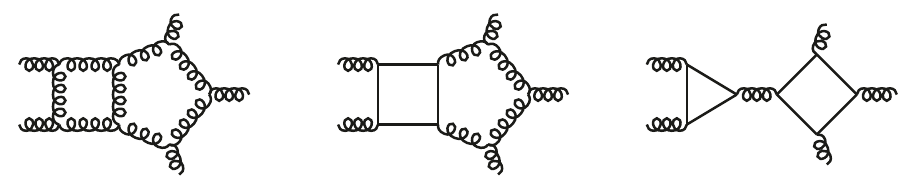
Figure 1 . Representative Feynman diagrams for leading-color A (2) ( g; g; g; g; g ) amplitudes, con- tributing at order N 0